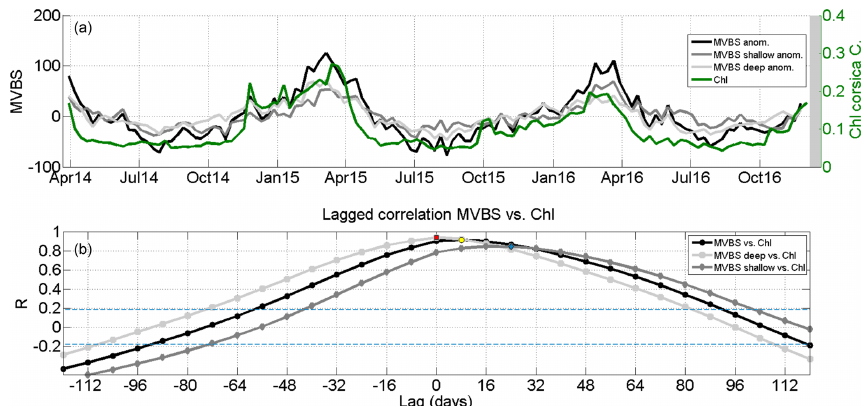
Figure 7. (a) Time series of integrated anomalies of MVBS (whole water column; dB re(4 π m) − 1 ) , MVBS in the layer 73–201m (MVBS shallow), MVBS in the layer 201–378m (MVBS deep) and surface chlorophyll a concentration from satellite data (Chl a in mgm − 3 ) at the mooring location in the Corsica Channel. (b) Lagged correlation analysis between MVBS (whole water column, shallow, deep) and Chl a . Blue lines indicate the 95% confidence bounds. The red square, the yellow circle and the blue diamond indicate the maximum significant correlation at lags of 0, 8 and 24d, respectively, between deep MVBS and Chl a , total MVBS (top–bottom) and Chl a , and shallow MVBS and Chl a